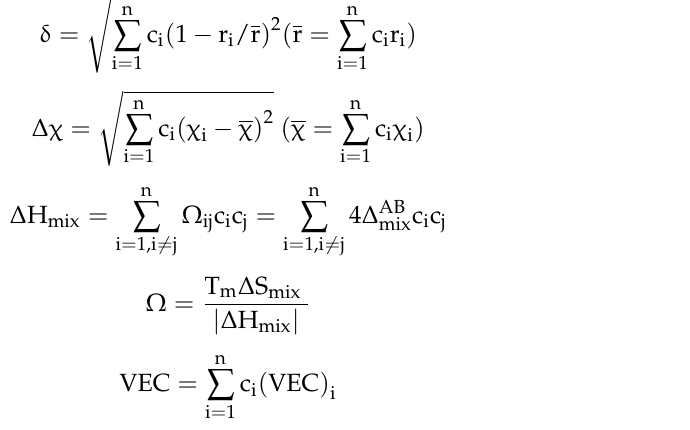
Figure 1. XRD results of ( a ) pristine α -Fe, CrFeV, and AlCrFeV and ( b ) irradiated samples. The microstructure of the alloys after polishing and prior to irradiation are shown in Figure 2. It can be seen from the SEM back-scattered images that all alloys exhibit a coarse equiaxed grain structure with sizes ~200 μ m and not any other microstructural characters were found. The XRD and SEM results verify that CrFeV and AlCrFeV both have single bcc structures. Additionally, the inserted EDS-mapping results show that the distribution of these elements in the materials is extremely homogeneous. It should be noted that the alloys are nominal equiatomic alloys, and the actual contents were characterized by SEM- EDS. The measured atomic percent of elements are displayed in Table 1. Considering the element evaporation in the preparation process, the atomic percentages of elements are nearly equal.